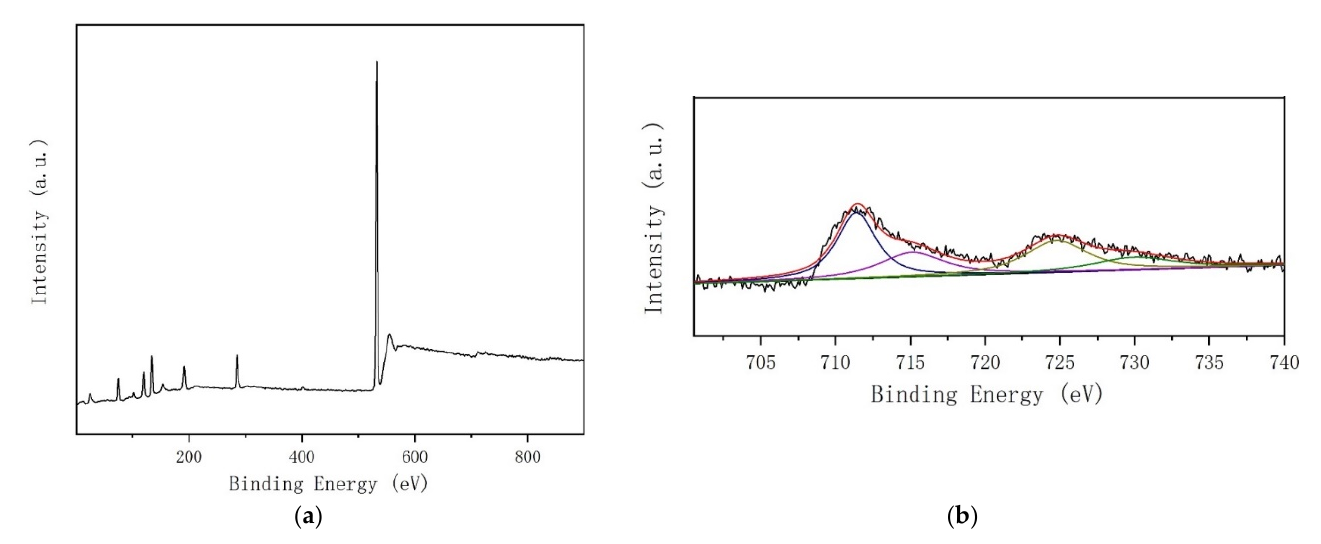
Figure 4. FeO x /SAPO-34-3 molecular sieve sample prepared by an impregnation method: ( a ) Full XPS spectrum, ( b ) Fe 2p spectrum.